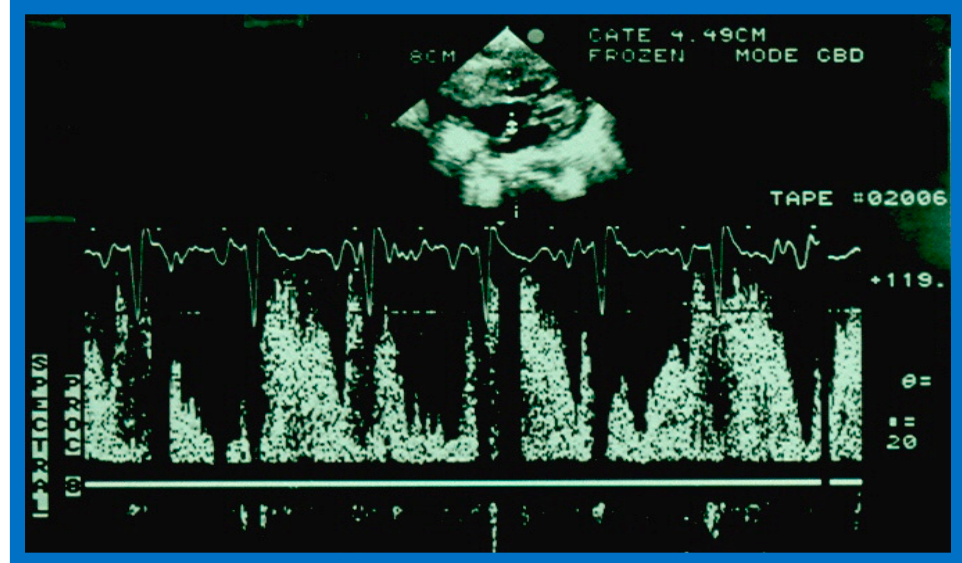
Figure 5. Selected video frame demonstrating flow across an atrial septal defect (ASD) by pulsed Doppler by placing the sample volume on the right side of the ASD (top insert).